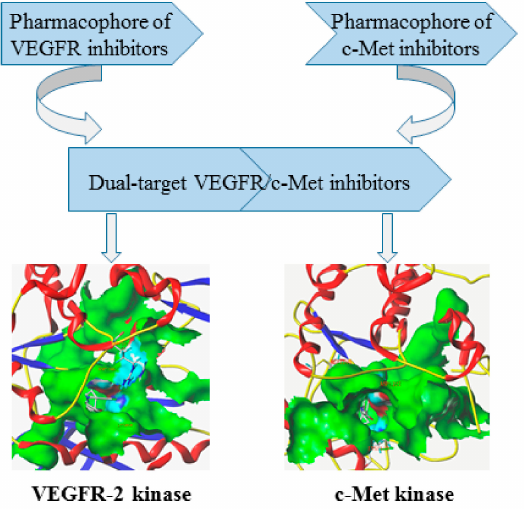
Figure 2. Design of dual-target VEGFR / c-Met kinase inhibitors (PDB code: 3U6J,